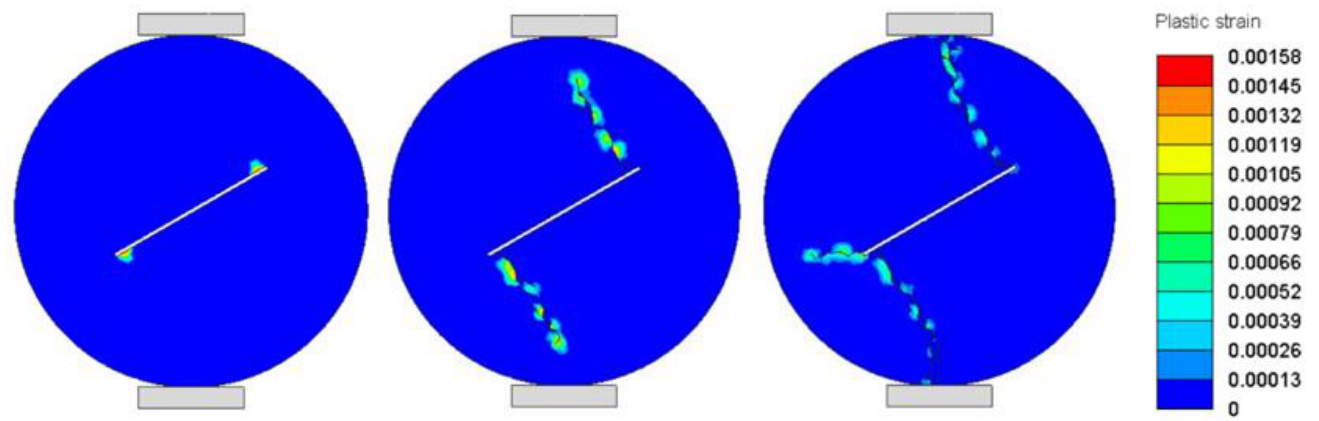
Figure 20. Plastic strain evolution for Brazilian disc with a crack of 45° angle.